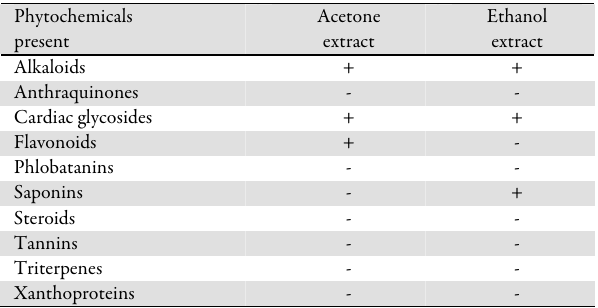
Table 2. The results of phytochemical screening of H. involuta